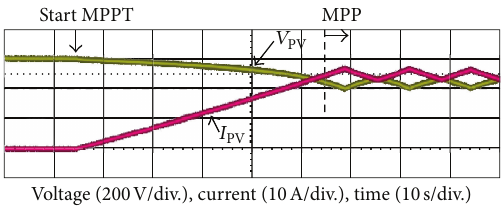
Figure 8: Startup behavior of the MPPT control.